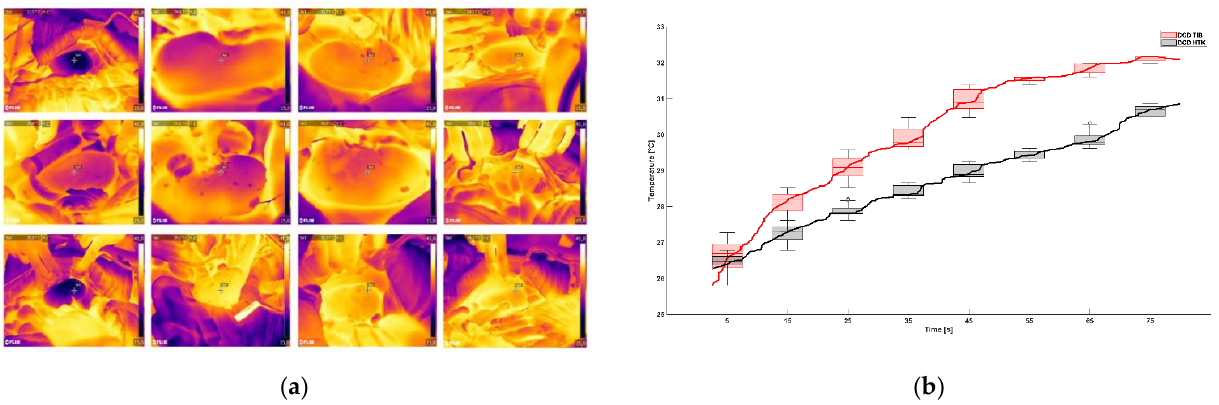
Figure 4. Thermographic Imaging. ( a ) Exemplarily illustration of the thermal camera imaging during reperfusion. ( b ) The graph shows the determination of surface temperature over time of 80 s. Red line corresponds to the HTK control group, black line to the TIB group. p adjusted p = 0.76, 2-Way ANOVA Kruskal-Wallis